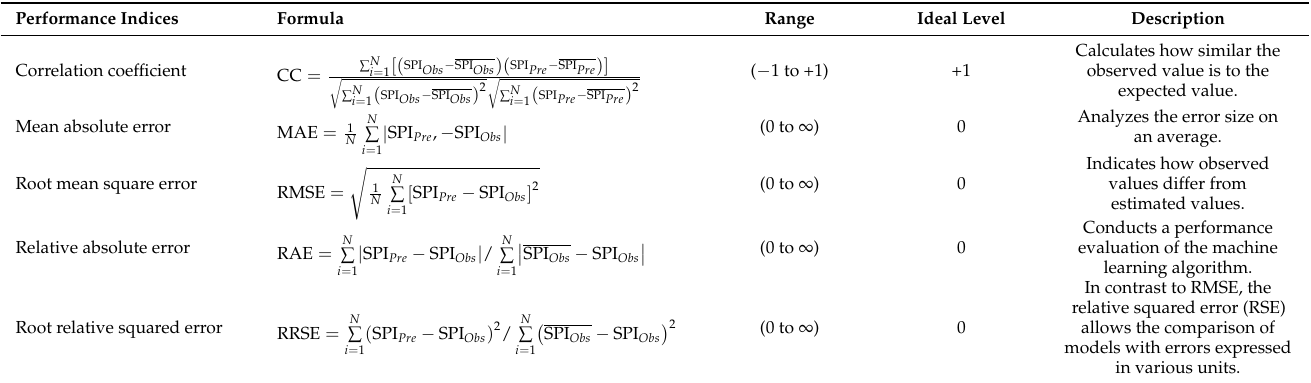
Table 3. Descriptions of indices for data mining techniques supported by mathematical